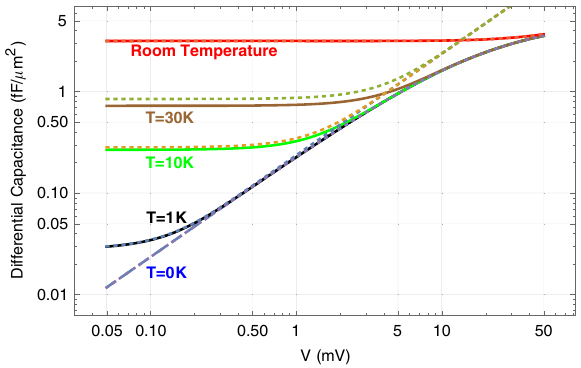
Fig. 2 The differential capacitance of the proposed layered structure at various temperatures on the logarithmic scale. Dashed line is the zero temperature limit. Dotted lines correspond to the quantum capacitance C Q only, without taking the effect of geometric capacitance C G into